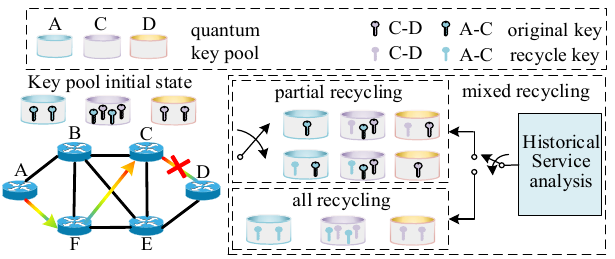
Figure 7. QKR mechanism and three recycling methods: (a) partial recycling, (b) all recycling, and (c) mixed recycling.